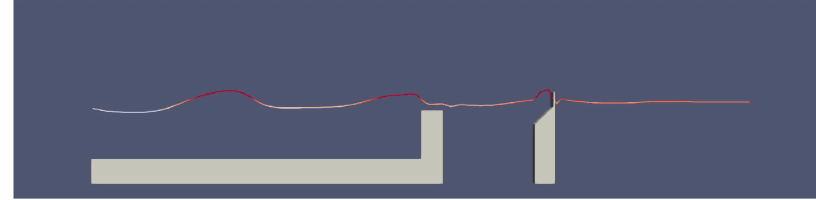
Figure 8. Free surface elevation at t = 22.7 s in the numerical simulation.